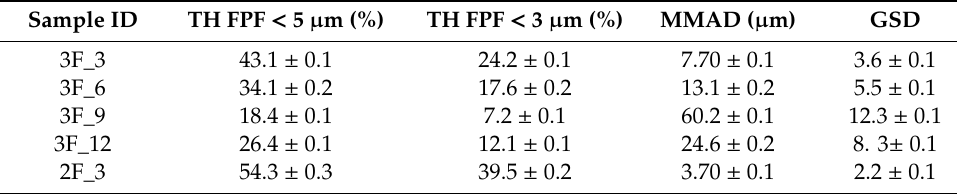
FPF: Fine particle fraction; MMAD: Median mass aerodynamic diameter; GSD: Geometric standard deviation. Table 4. Salbutamol sulphate aerosolisation performances of the spray-dried formulations. Sample ID